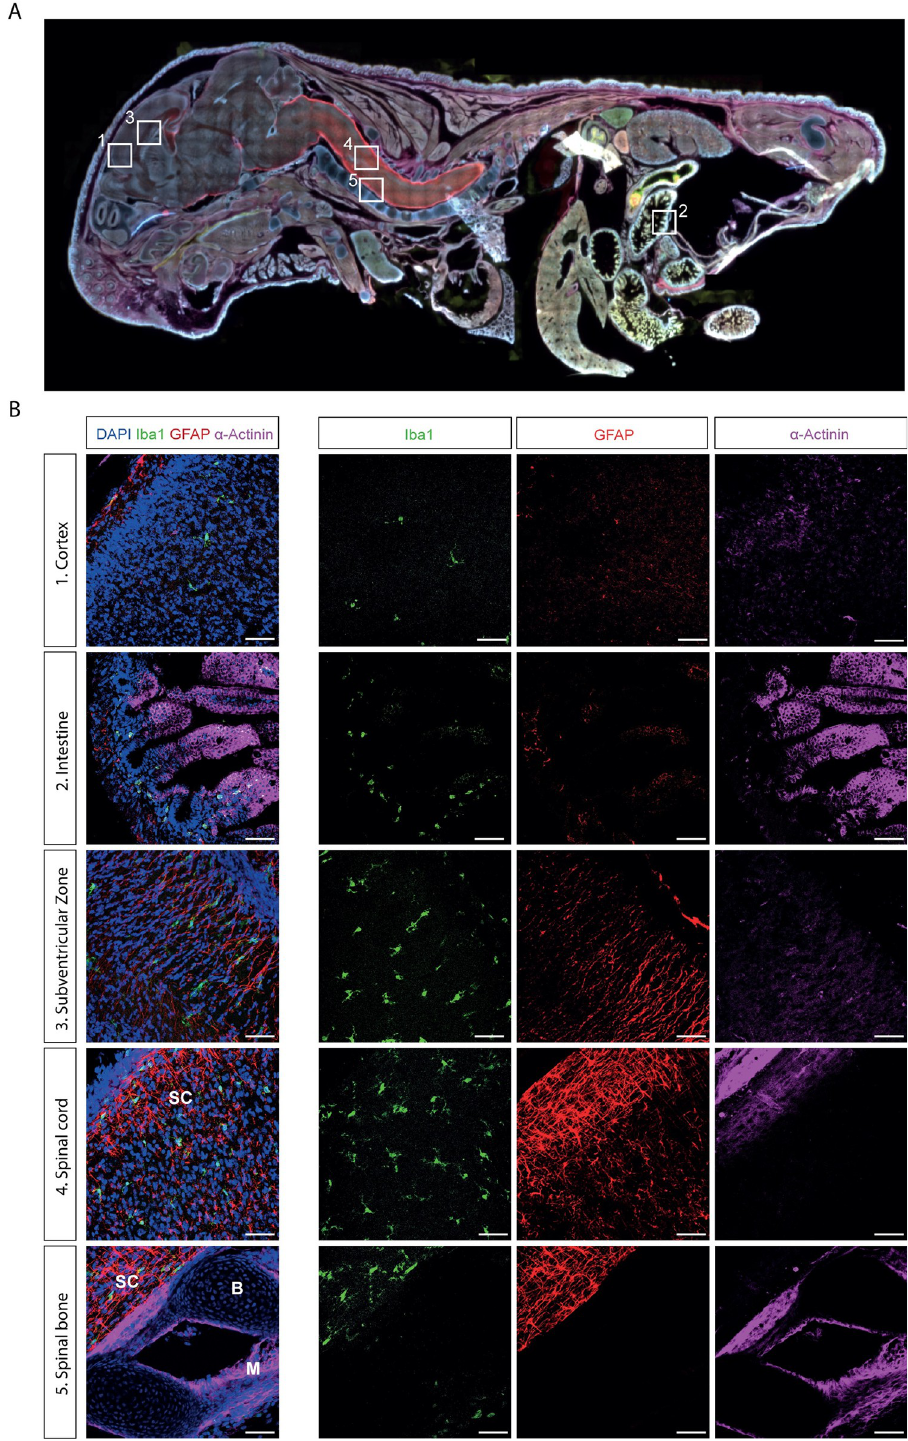
Fig 2. Immunohistochemistry of neonatal perfused mouse tissue. a. Whole body staining (magnification: 10x) (blue: DAPI, red: GFAP, green: Iba1, magenta: α -Actinin) b. Magnified (magnification: 30x) images of different regions of the previous staining (1. Cortex, 2. Intestine, 3. Subventricular Zone, 4. Spinal cord, 5. Spine) (blue: DAPI, red: GFAP, green: Iba1, magenta: α -Actinin). Scale bar: 500 μ m. SC: Spinal cord, B: bone, M: muscle.